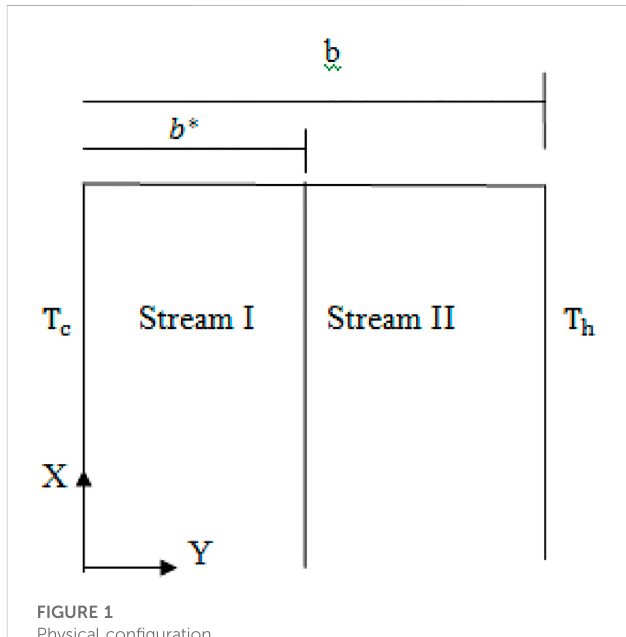
FIGURE 1 Physical con fi